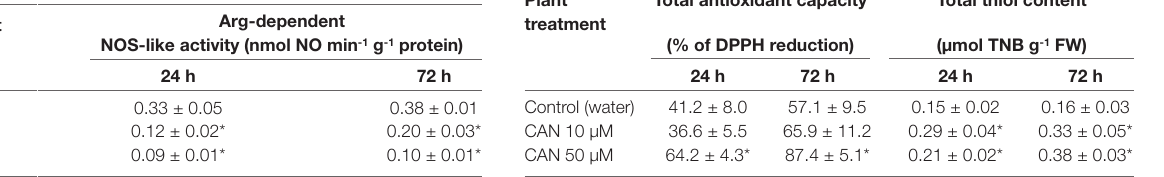
TABLE 1 | Arg-dependent NOS-like activity in extracts from roots of the control plants grown in water or from roots of tomato seedlings treated with CAN (10 or 50 µM) for 24 and 72